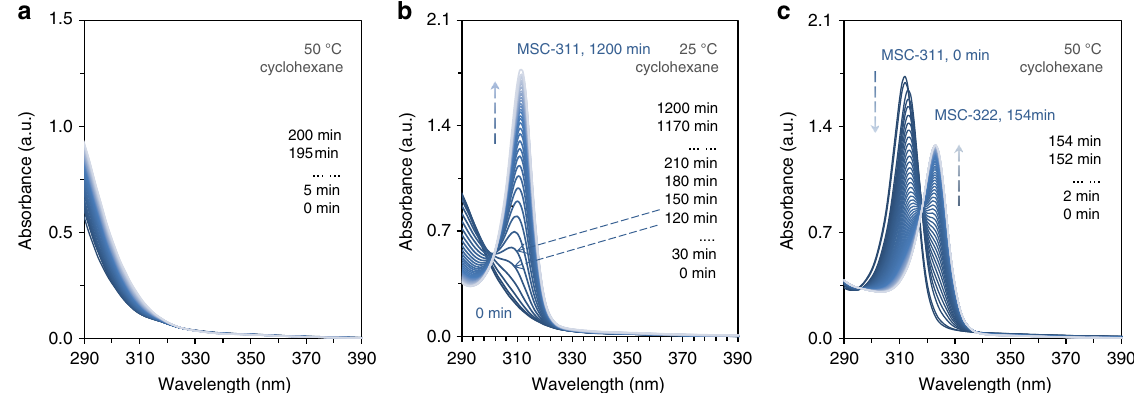
Fig. 6 In situ time-resolved absorption spectra collected from one cyclohexane dispersion. When the sample (~31 mg prepared similar as that for Fig. 1) was dispersed in cyclohexane (3 mL) at 50 °C ( a ), there was a limited change in absorbance observed at 322 nm for up to 200 min (from dark blue to gray). When this dispersion was cooled to 25 °C, MSC-311 started to develop around 2 h ( b ). When this dispersion (after 20 h at 25 °C) was then placed at 50 °C, a MSC-311 ⇒ MSC-322 transformation readily took place ( c ). Therefore, the evolution of MSC-322 via the solid – solid phase transformation from MSC-311 in dispersion at 50 °C ( c ) appears to be much more ef fi cient than that the liquid – solid phase transformation from the IP in dispersion at 50 °C ( a ) NATURE COMMUNICATIONS| (2018) 9:2499 |DOI: